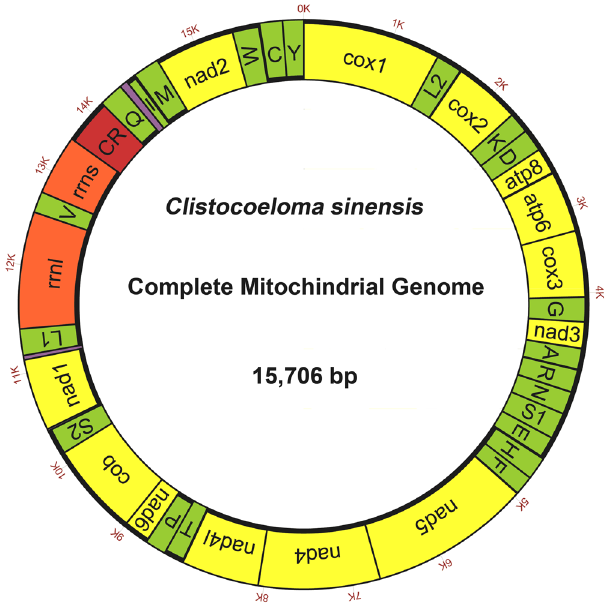
Figure 1. Graphical map of the mitogenome of Clistocoeloma sinensis . Protein-coding and ribosomal RNA genes are shown using standard abbreviations. Genes for transfer RNAs are abbreviated using a single letter. S1 = AGN, S2 = UCN, L1 = CUN, L2 = UUR. CR = control region. The 13 protein-coding genes are yellow, tRNAs are green, rRNAs are red, and CRs are dark red.